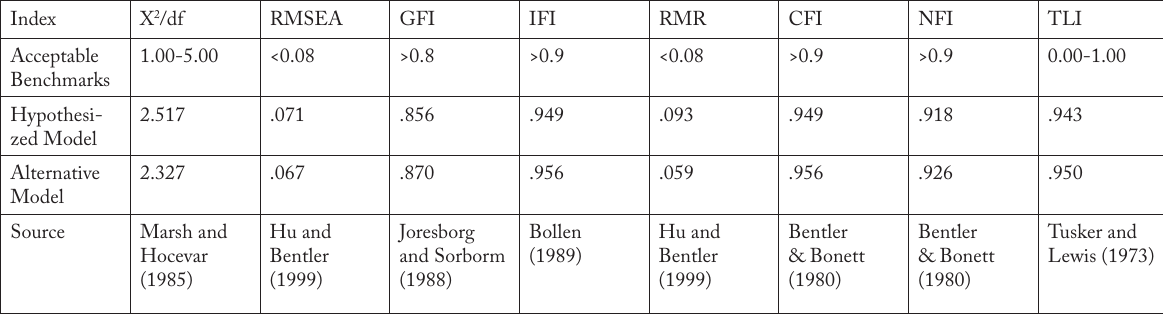
Table 8. Model fit indicators for the hypothesized and alternative models.